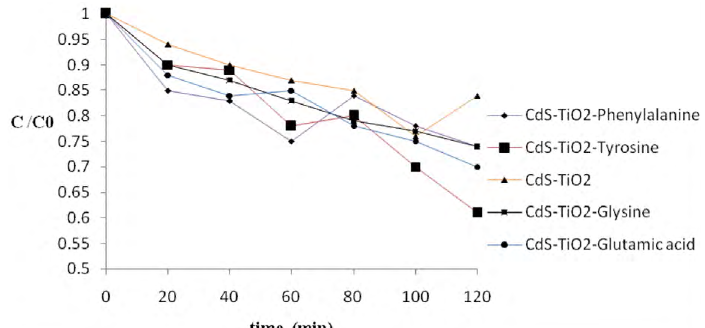
Fig. 8. Effect of surface modification on the adsorption capability (catalyst: 0.1 g, NB: 0.0136 M).